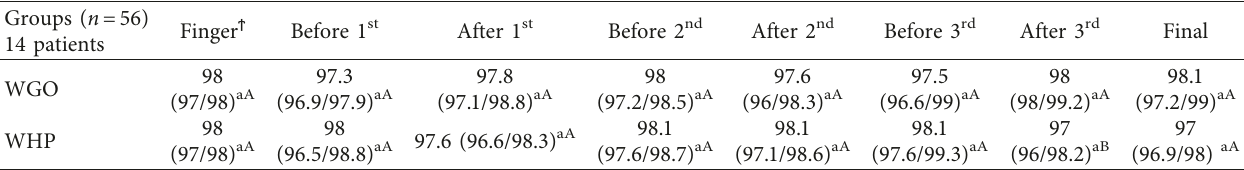
Table 2: Medians (first/third quartiles) of the oxygen saturation levels measured at different periods of reading (before and after the first , second , and third bleaching session and at the final , that is, 1 week after the third session) for the different whiteners used: Whitegold Office 35% (WGO) and Whiteness HP Auto Mixx 35% (WHP) ∗ .